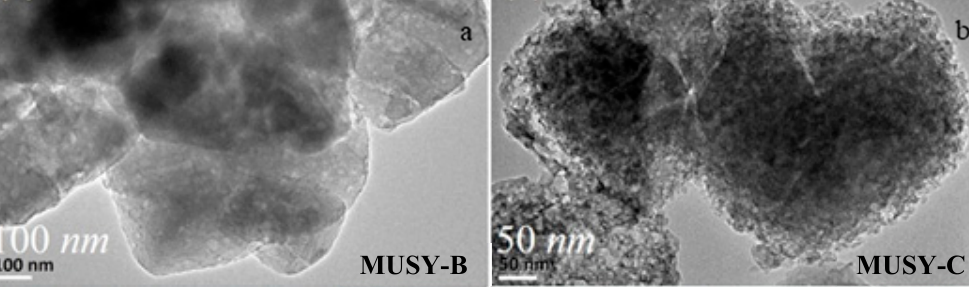
Figure 3. TEM images of the zeolites. MUSY-B ( a ) and MUSY-C ( b ).